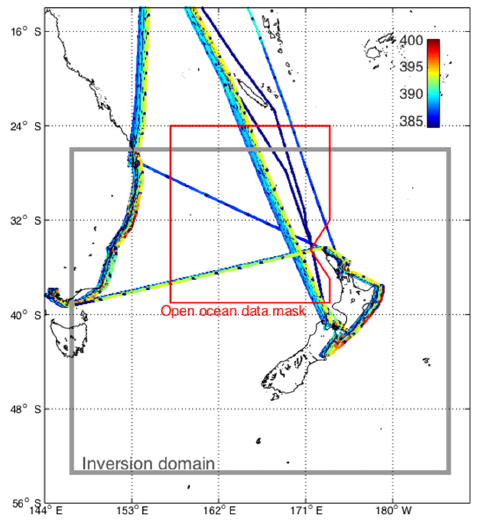
Figure 3. Voyages of the Ship of Opportunity Trans Future 5 . Ship tracks have been slightly spread longitudinally to allow one to dif- ferentiate individual cruises (more recent cruises are to the right). Colours give the in situ CO 2 concentration. Measurements made inside the open-ocean mask were used in the northern baseline anal- ysis. The inversion domain is outlined in